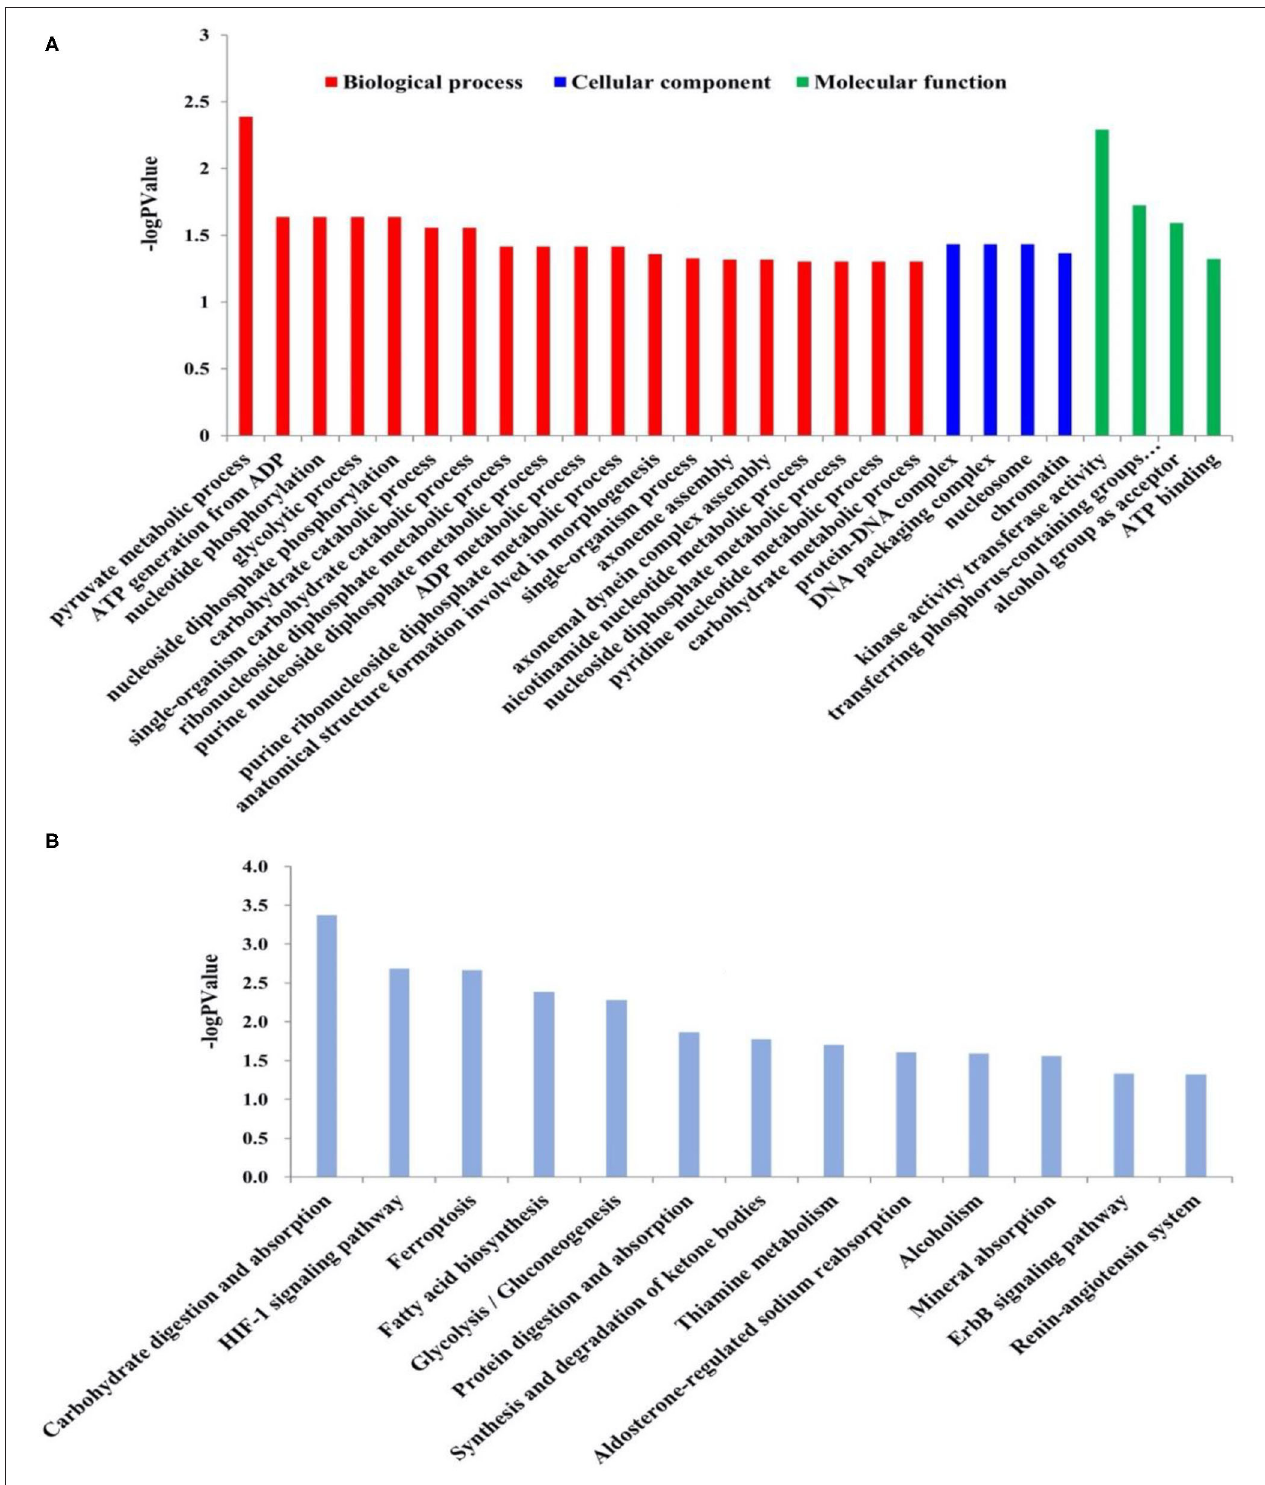
FIGURE 3 | (A) GO enrichment analysis of the DEGs in LD of fattening yaks and grazing yaks. The GO terms belonging to biological processes, cellular components and molecular functions were shown in red, blue, and green, respectively. The significance levels were P < 0.05. (B) KEGG pathway analysis of the DEGs in LD of fattening yaks and grazing yaks. The significance levels were P <